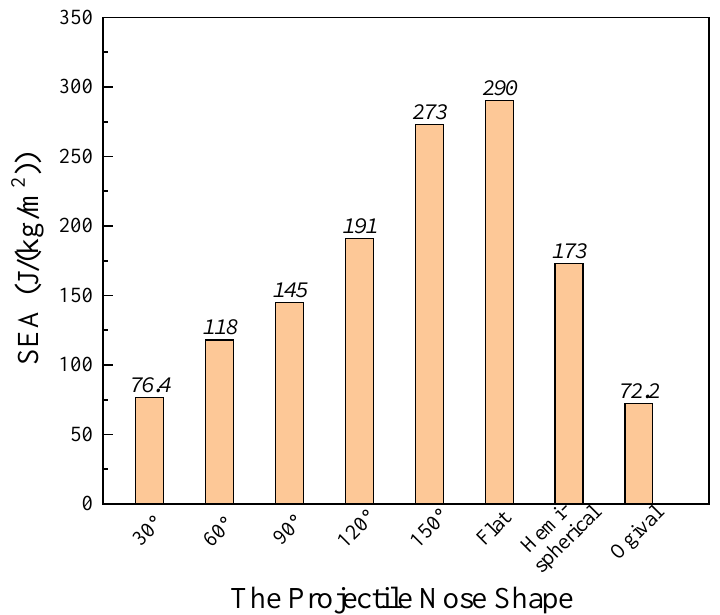
Figure 5. The specific energy absorption (SEA) of the UHMWPE composite impacted various nose shape projectiles.